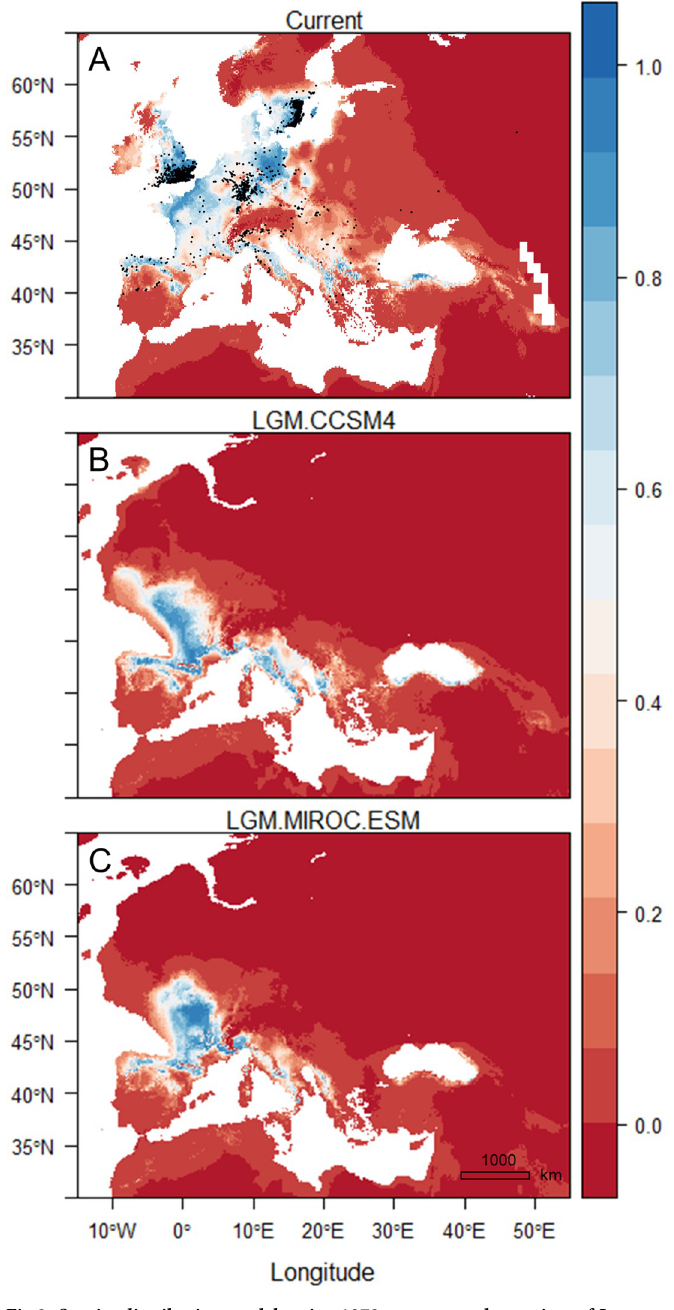
Fig 9. Species distribution models using 1279 occurrence data points of Lucanus cervus . (A) The current distribution with the occurrence records (black dots), the distribution during the Last Glacial Maximum based on two general circulation models, (B) CCSM4 and (C) MIROC-ESM. The legend indicates low (0) to high (1) environmental suitability for L . cervus